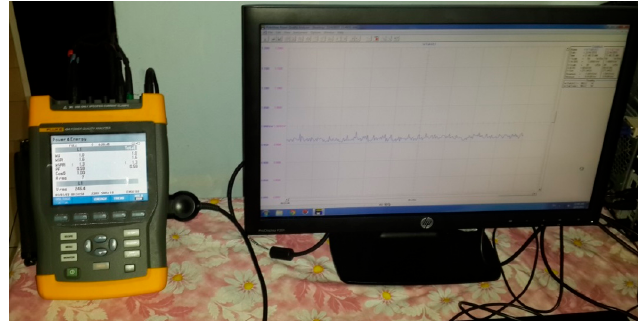
Figure 8. Power quality analyzer to measure the power consumption.